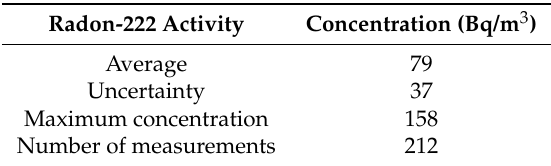
Table 2. Concentration before applying any